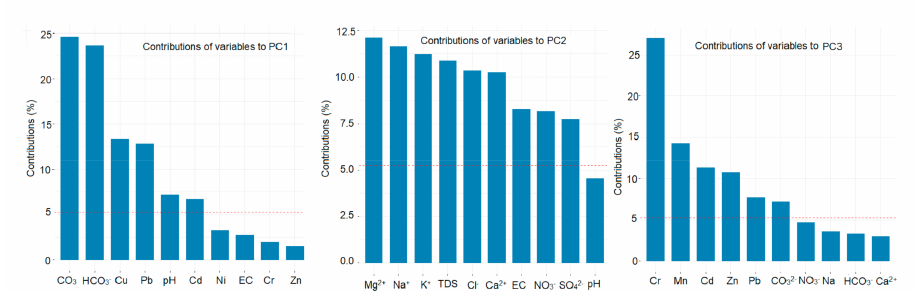
Figure 8. Contributions (%) of the variables on PC1, PC2, PC3.